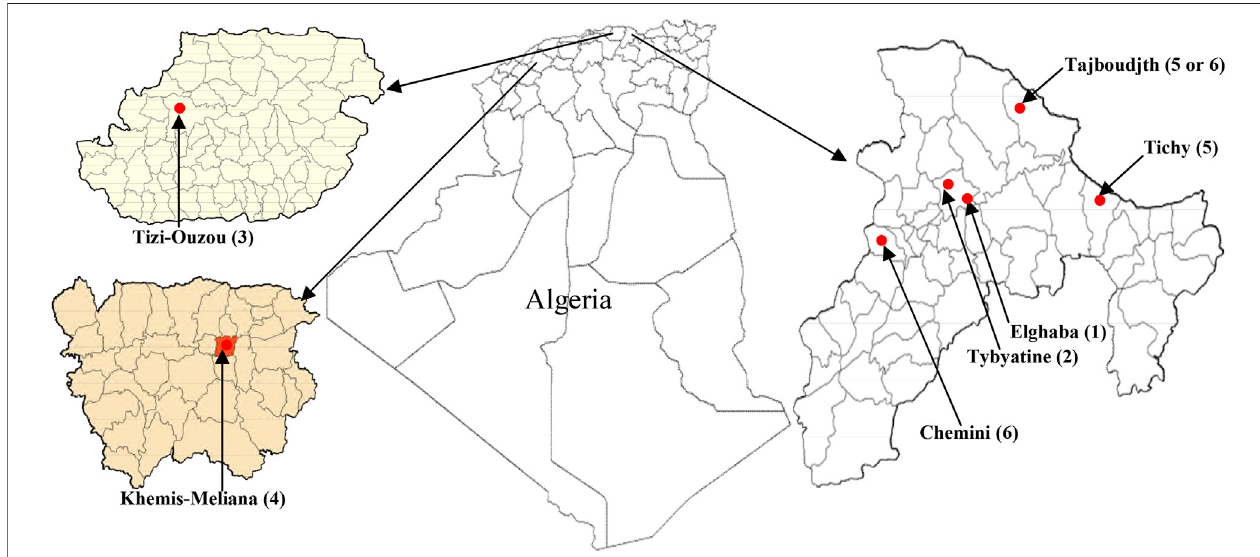
FIGURE 1 | Map of Mentha sampling localities in Bejaia, Tizi-Ouzou, and Ain De fl a (Khemis – Miliana) departments from Algeria.